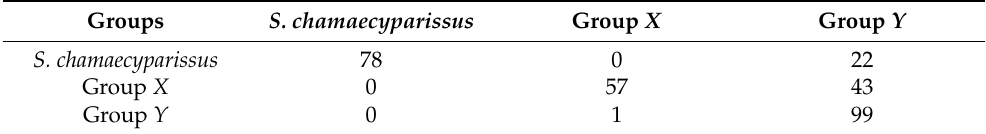
Table 11. Results of the Random Forest analysis applied to the three Santolina haplotype groups detected by the molecular analysis. Group X is composed of the populations of S. insularis from Buggerru and San Benedetto (the type locality). Group Y is composed of the populations from Mont Pigno (Corsica, type locality) and by the remaining populations of S. corsica and S. insularis from Sardinia. Values are